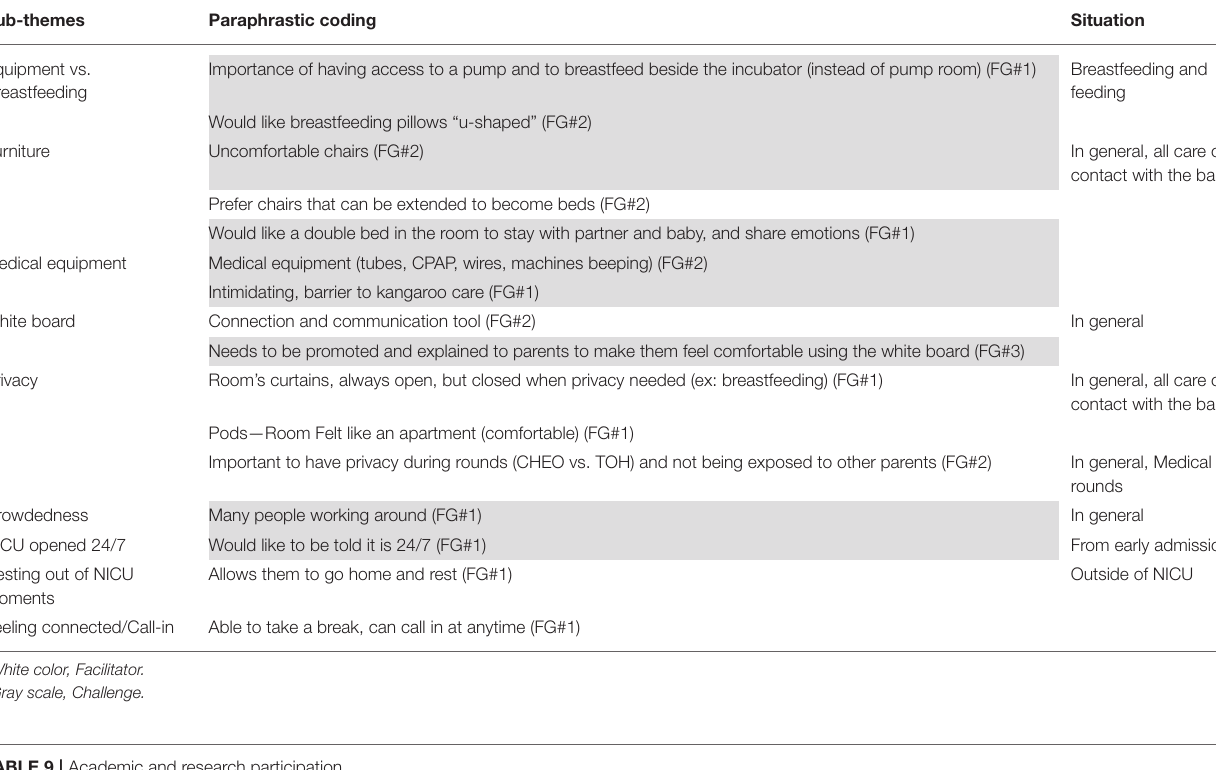
Breastfeeding and feeding